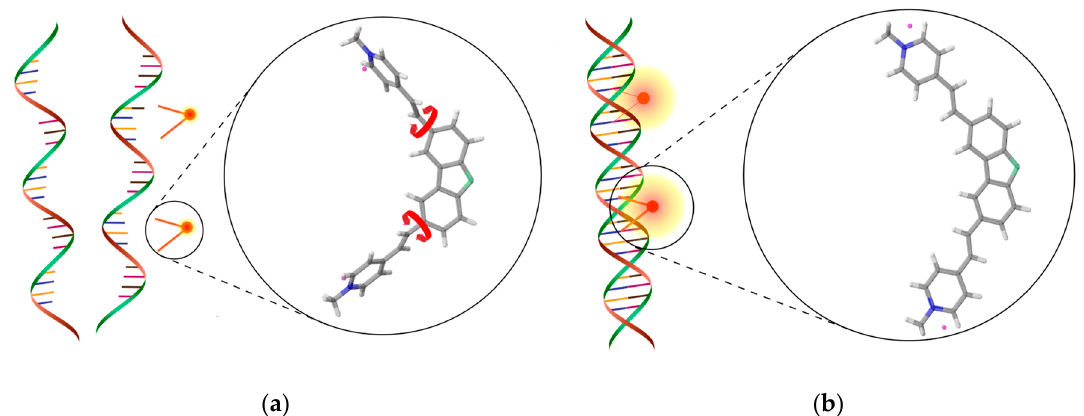
Figure 2. The turn-on phenomenon of the V-carbazole fluorescent molecule. ( a ) OFF state: V-carbazole molecules are free in the solution. The red arrows indicate that the two arms can rotate freely, resulting in a weak fluorescence signal. ( b ) ON state: V-carbazole molecules are bound to dsDNA. The two arms are restricted from rotation, resulting in fluorescence signal enhancement.